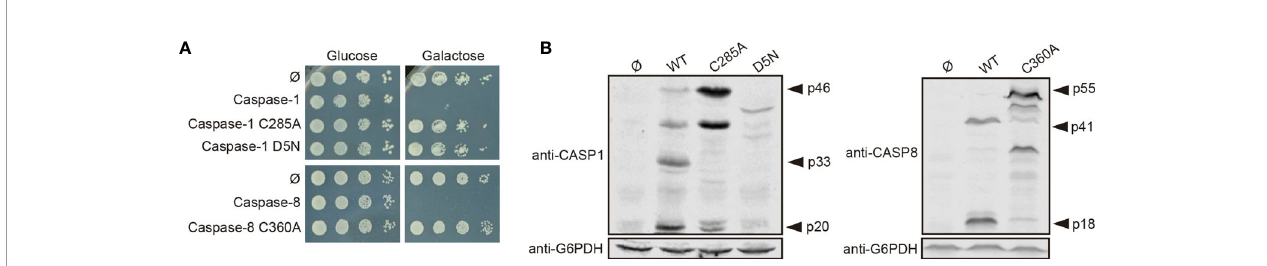
FIGURE 2 | Caspase-1 and caspase-8 toxicity is a consequence of their proteolytic activity. (A) Yeast spot assay performed as in Figure 1B but using BY4741 strain bearing pAG413-caspase-1, pAG413-caspase-8, or plasmids bearing their respective catalytically inactive mutants pAG413-caspase-1 C285A and pAG413- caspase-8 C360A, and the uncleavable mutant pAG413-caspase-1 D5N. (B) Immunoblots showing the expression in yeast lysates of cells bearing the same plasmids as in panel (A) after 5 h of induction in SG medium. Membranes were hybridized with anti – caspase-1, and anti – caspase-8 antibodies. Anti-G6PDH antibody was used as a loading control. Representative assays from three different experiments with distinct transformants are shown in all